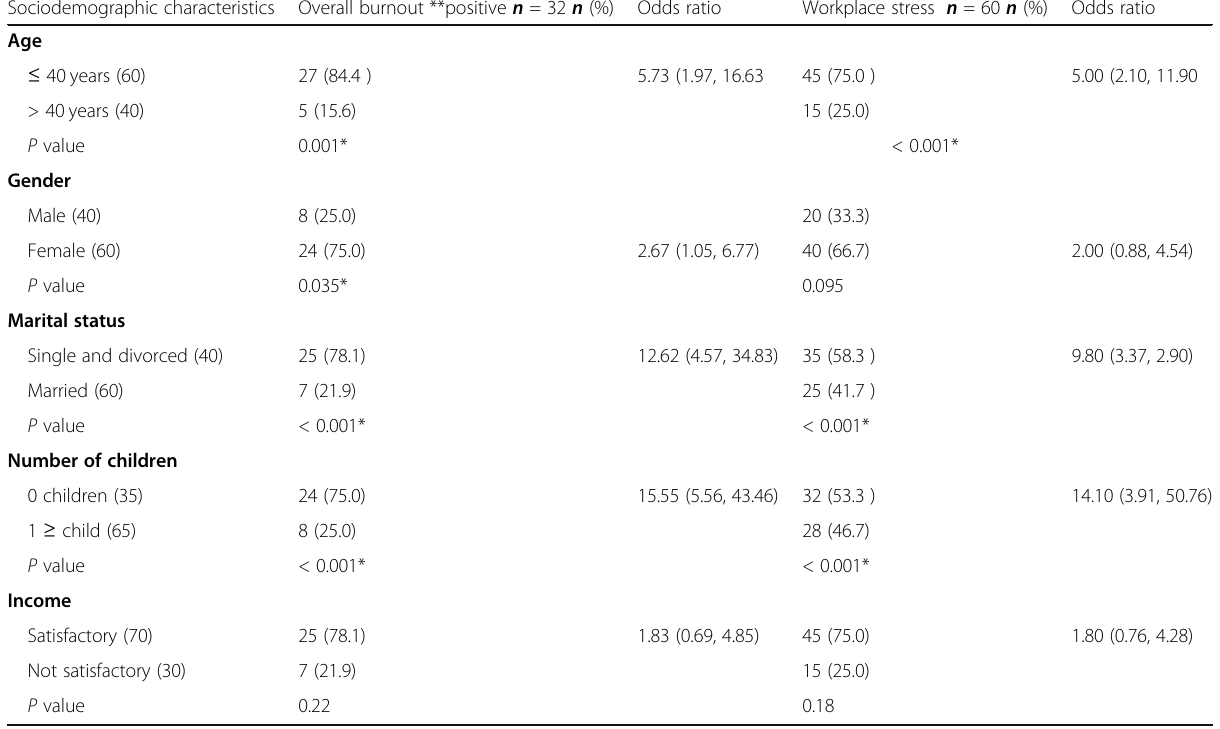
Table 4 Relation of burnout subscales and workplace stress to the sociodemographic data of the studied oncologists Sociodemographic characteristics Overall burnout **positive n = 32 n (%) Odds